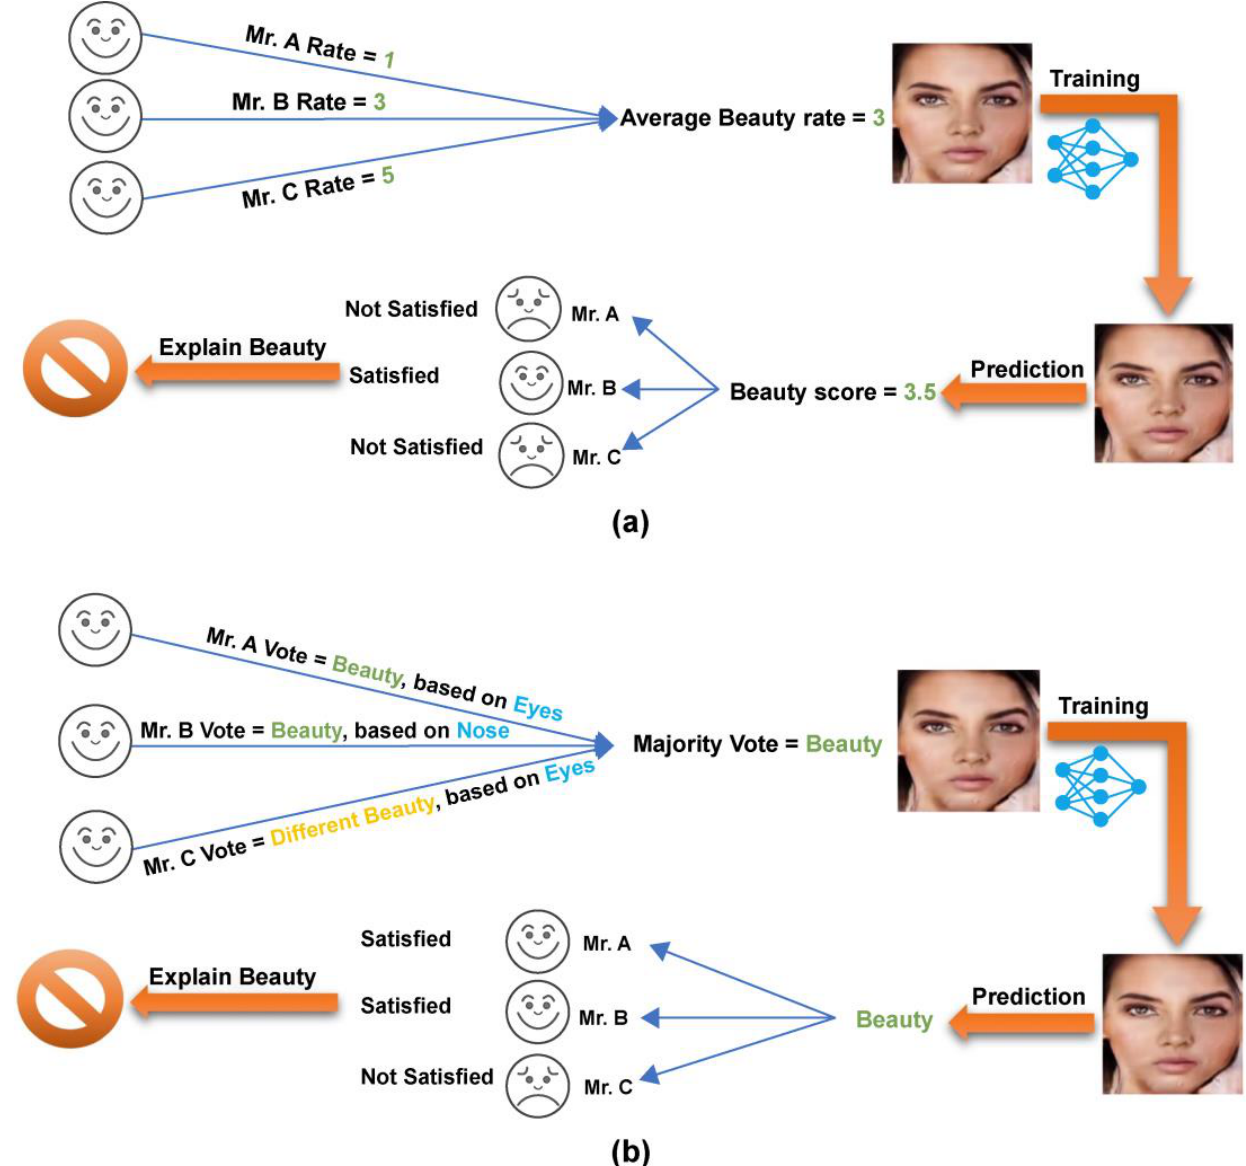
Figure 2. Illustration of the objective approach problem. ( a ) Approach based on average scores. ( b ) Approach based on voting.